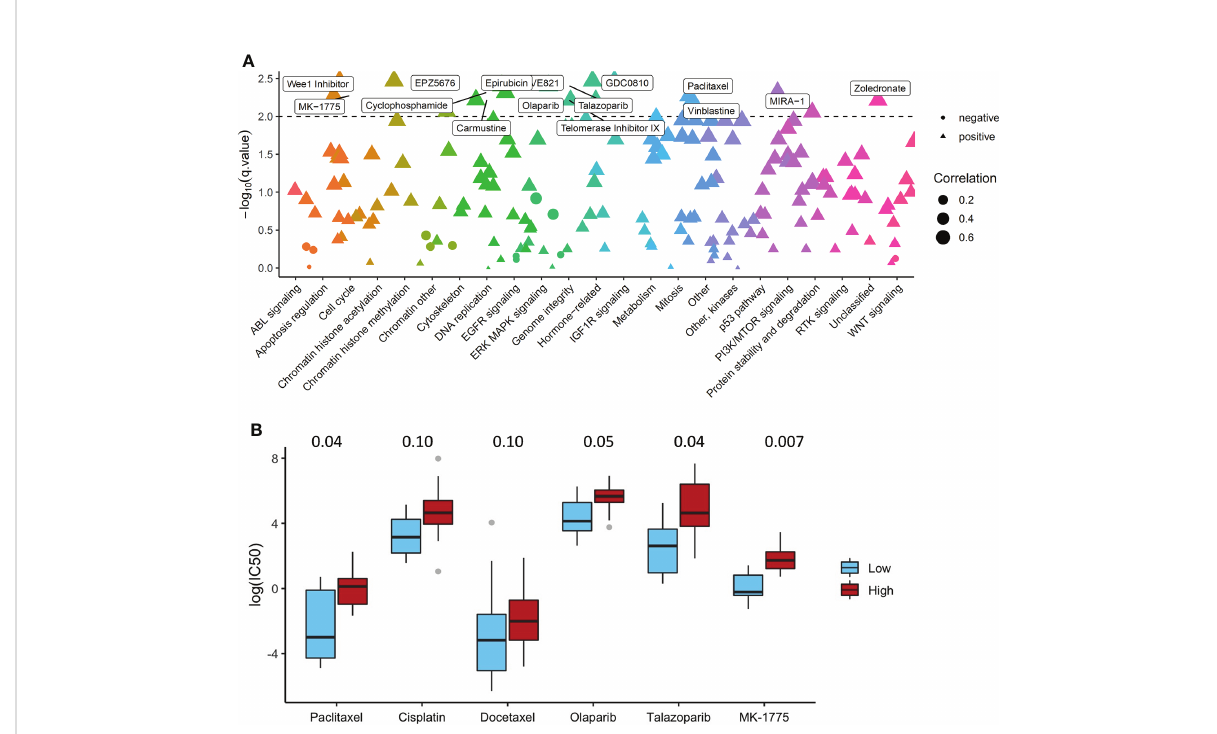
FIGURE 5 The Association of ADO score with Drug Sensitivity in GDSC dataset. (A) The Pearson correlation between ADO score and IC50 of the drugs in different biological pathways; (B) Boxplots of the IC50 for conventional and investigational drugs (P values were adjusted by Benjamini-